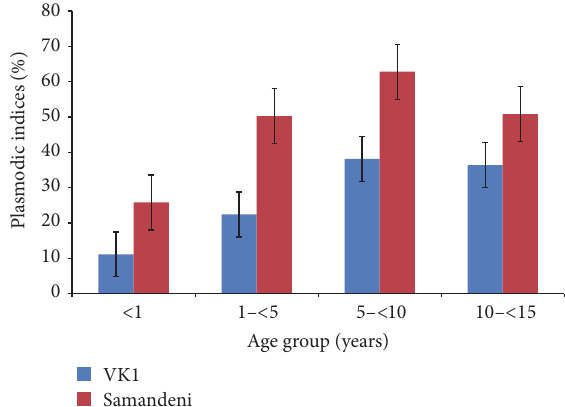
Figure 3: Plasmodic indices with standard errors bars (SEM) according to age (means ± SEM). When standard error bars (SEM) do not overlap, this means that the difference between two means is statistically significant ( 𝑃 < 0.05